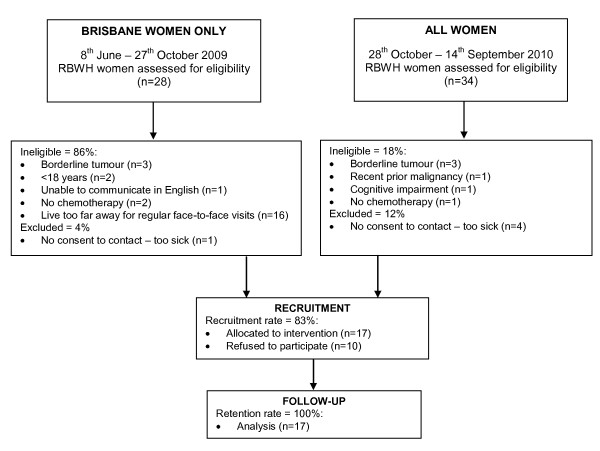
Participant recruitment, allocation and retention.